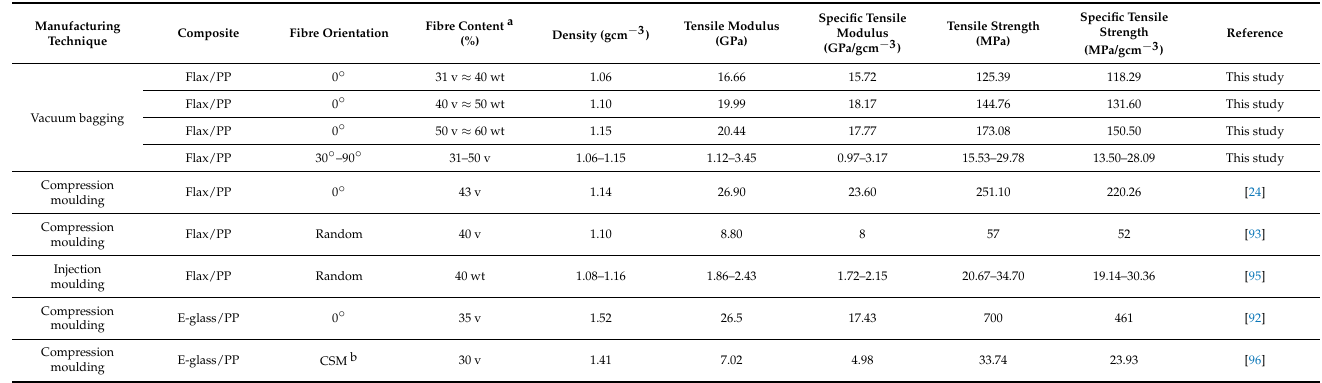
Table 2. A comparison of tensile properties of the manufactured flax/PP composites with E-glass/PP and flax/PP composites found in the